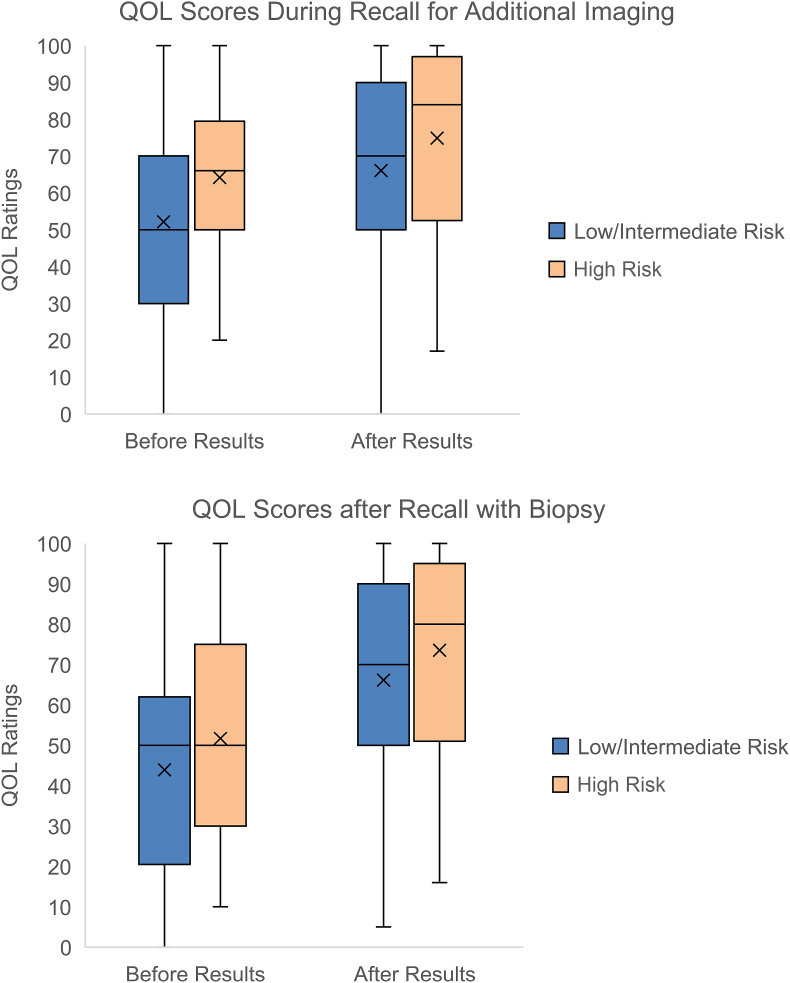
A–3B. QOL ratings by participants across risk categories (low/intermediate versus high) for scenarios of screening mammography recall with additional imaging (panel A) and biopsy (panel B). In both scenarios, QOL ratings significantly increased after receipt of benign results compared to before results were known (p < 0.05 for all scenarios). QOL ratings for each scenario did not differ by breast cancer risk category. Blue bars = low/intermediate risk women; orange bars = high-risk women. Means for each category are denoted by ‘X’.